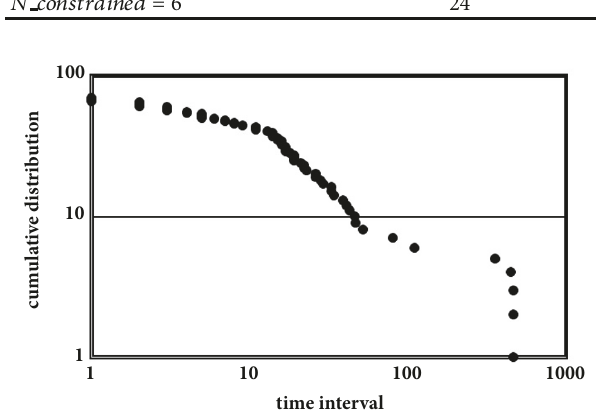
Figure 1: Tour period between any two consecutive pheromone depositions for